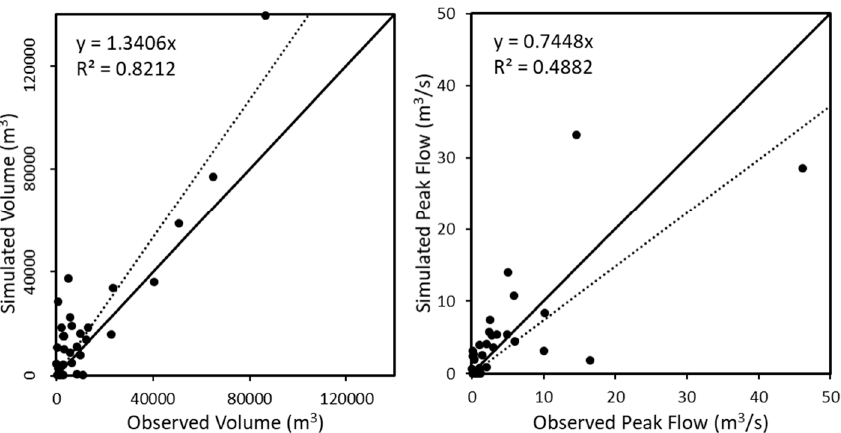
Figure 4. Validation of simulated runoff volumes ( left ) and simulated peak flows ( right ) at the watershed outlet as compared to observed values.